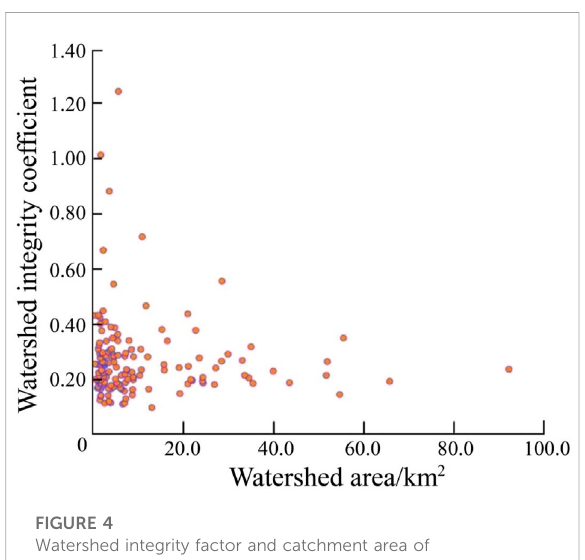
FIGURE 4 Watershed integrity factor and catchment area